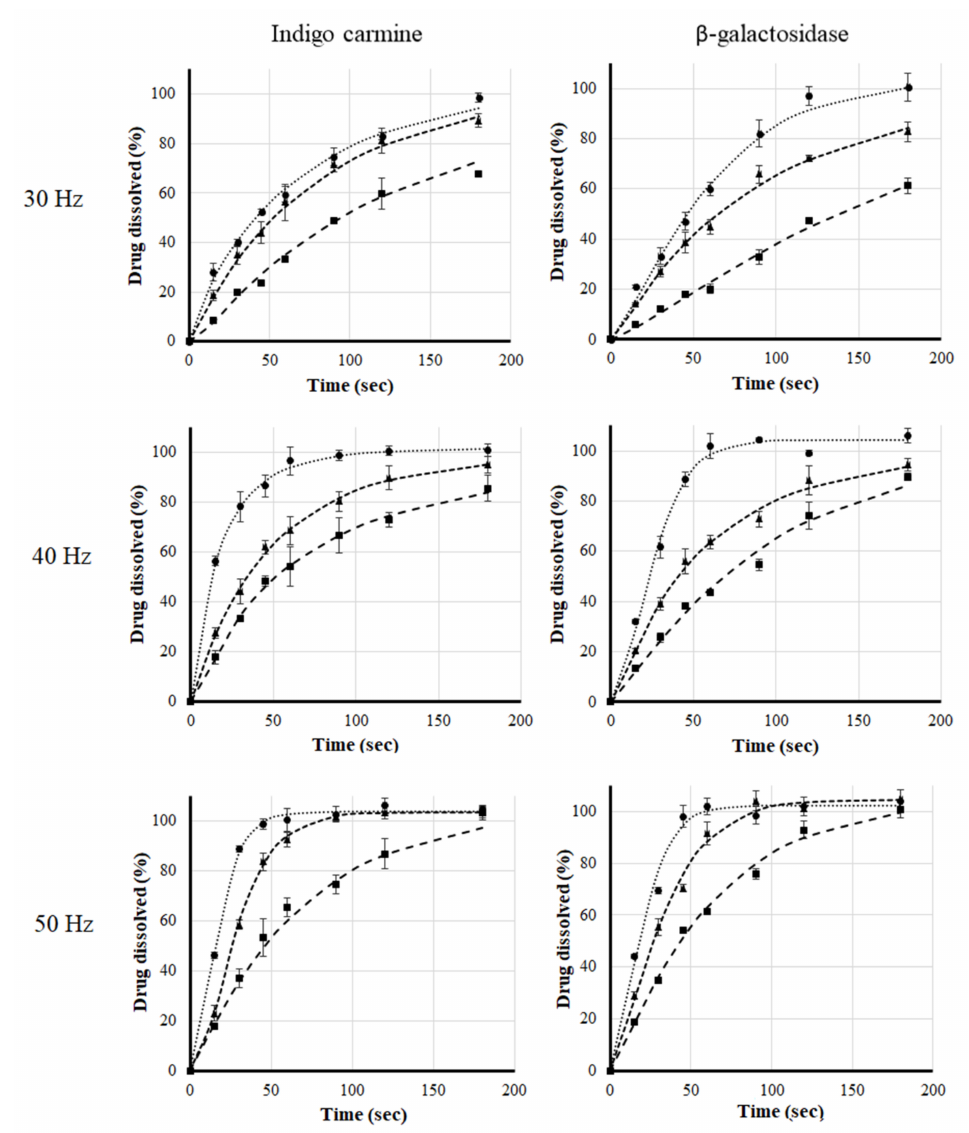
Figure 6. Indigo carmine (1st column) and β -galactosidase (2nd column) release profile ( • ; (cid:4) ; (cid:78) ; n = 3 ± SD) with fitted Weibull function (dotted lines). The pump frequencies are 30 Hz; 40 Hz or 50 Hz, and the fluid exhibiting different temperatures: 5 ◦ C ( (cid:4) ); 20 ◦ C ( (cid:78) ) and 35 ◦ C ( • ) during the